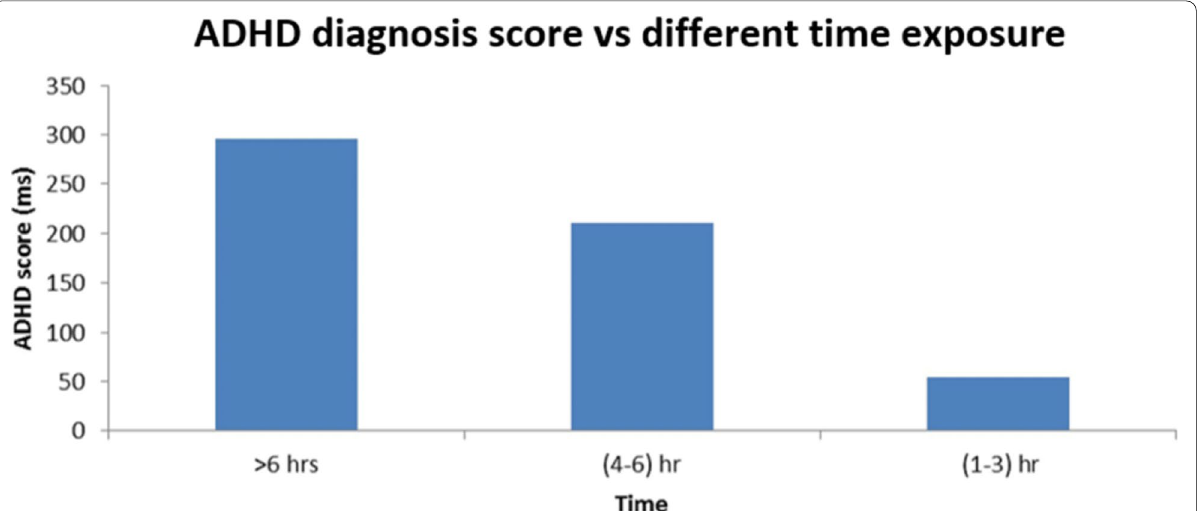
Fig. 2 Distribution of Attention-deficit/hyperactivity disorder score in different time exposure of digital device